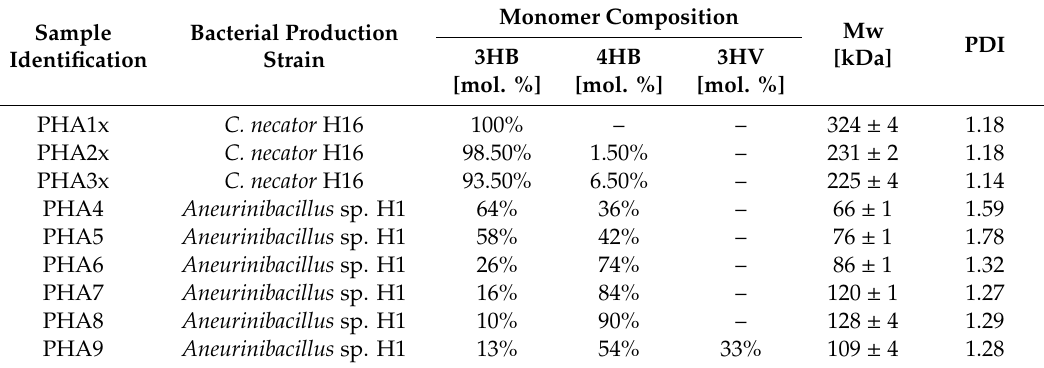
Table 1. Solvent-casted films from polyhydroxyalkanoates (PHA) copolymers analyzed in the